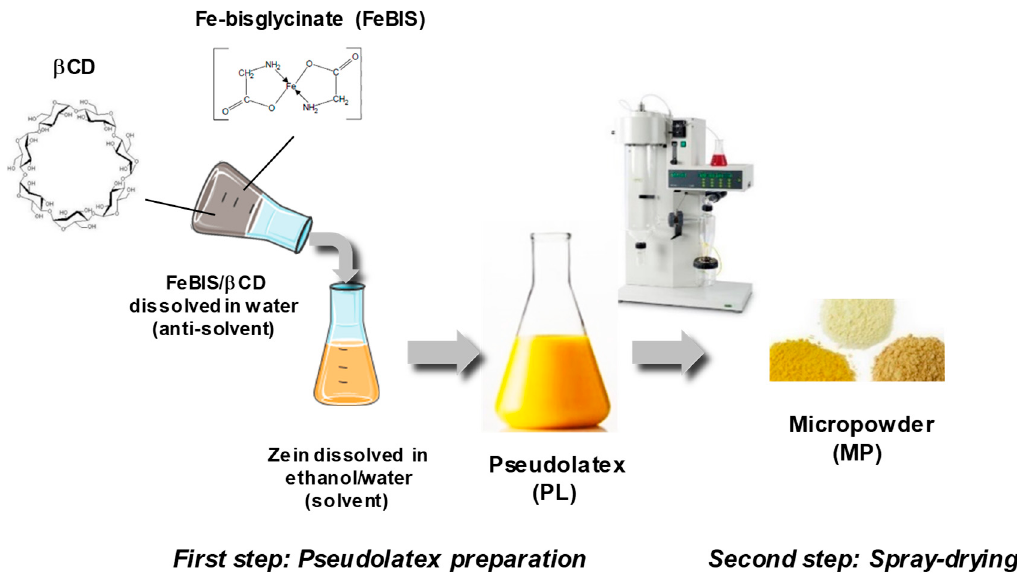
Figure 1. Schematic representation of the powder production process through the nano-in-micro strategy.